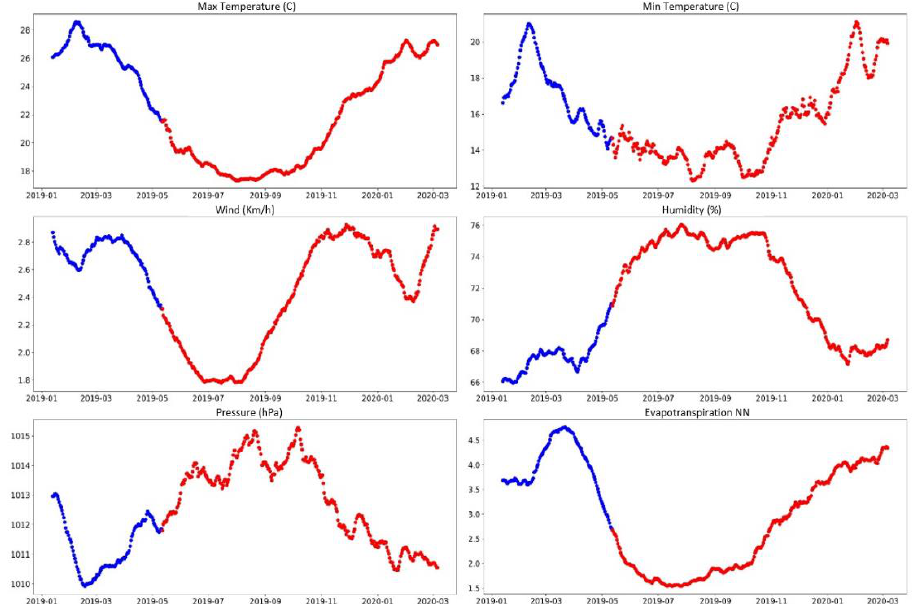
Figure 7. Blue color, original data; red color, predicted data. The figure shows the prediction for 300 days, using neural networks, of Maximum Temperature (°C), Minimum Temperature (°C), Wind Speed (km/hr), Moisture (%), Pressure (hPa), and Evapotranspiration (mm).